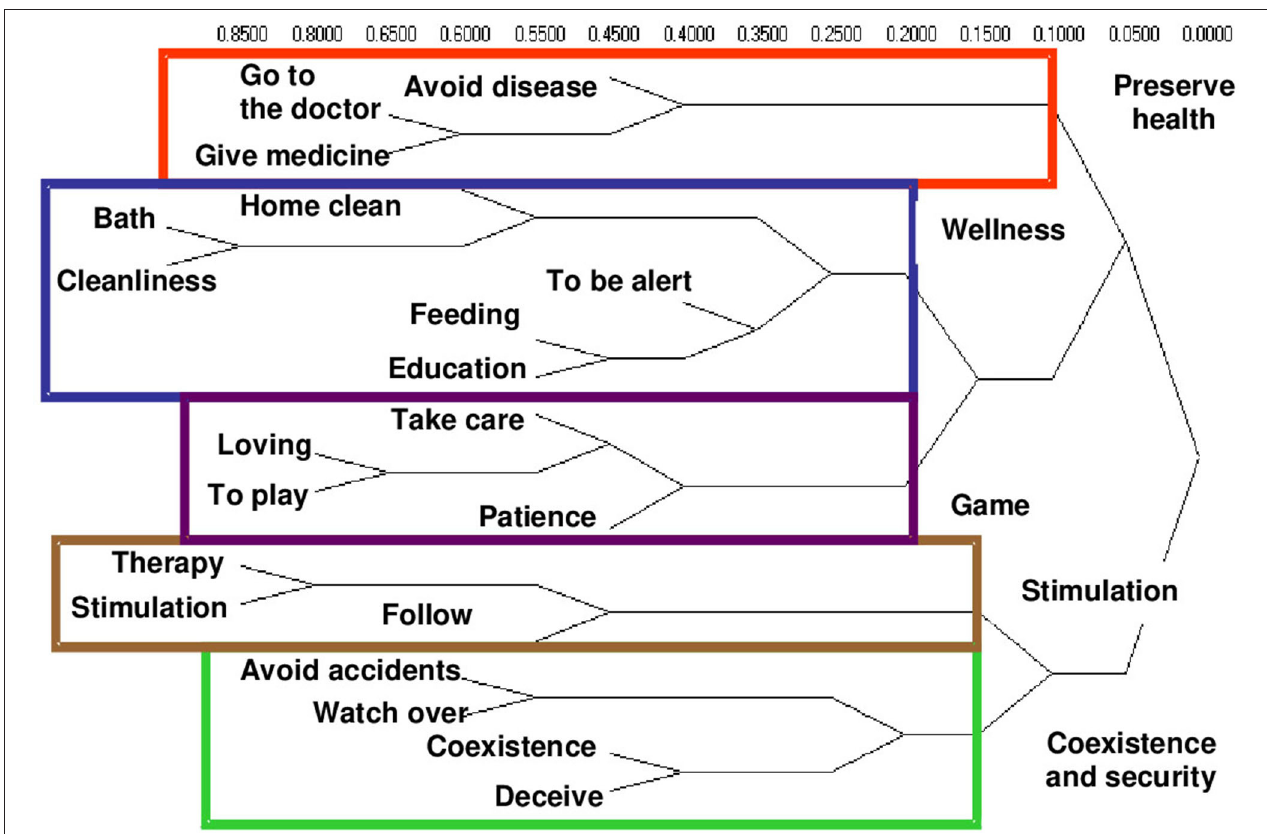
FIGURE 1 | Conceptual dimensions of child care by hierarchical conglomerates. Group 1. Caregivers of healthy